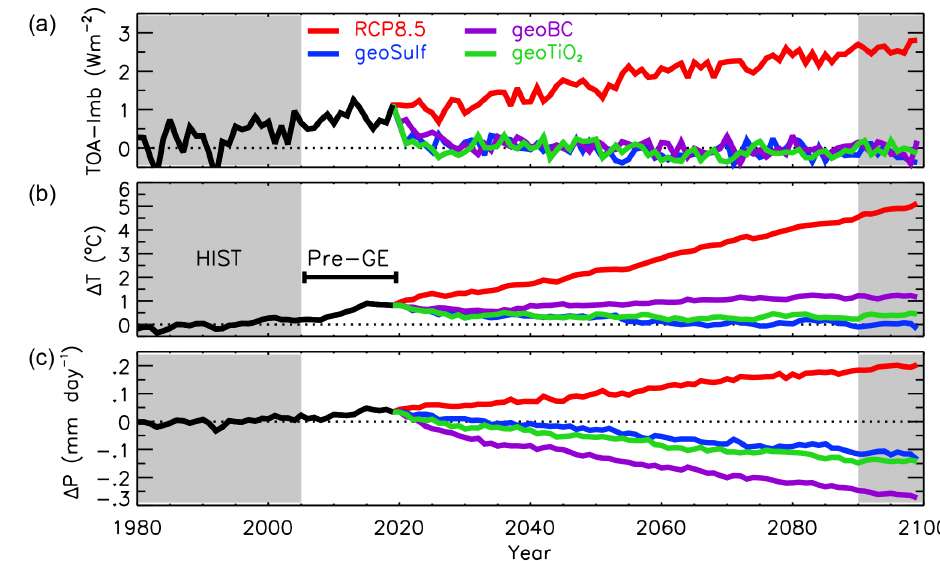
Figure 3. Time series of annual/global-mean (a) top-of-the-atmosphere radiative flux anomaly with respect to the pre-industrial control simulation, (b) near-surface air temperature anomaly with respect to the HIST period, (c) global mean precipitation anomaly with respect to